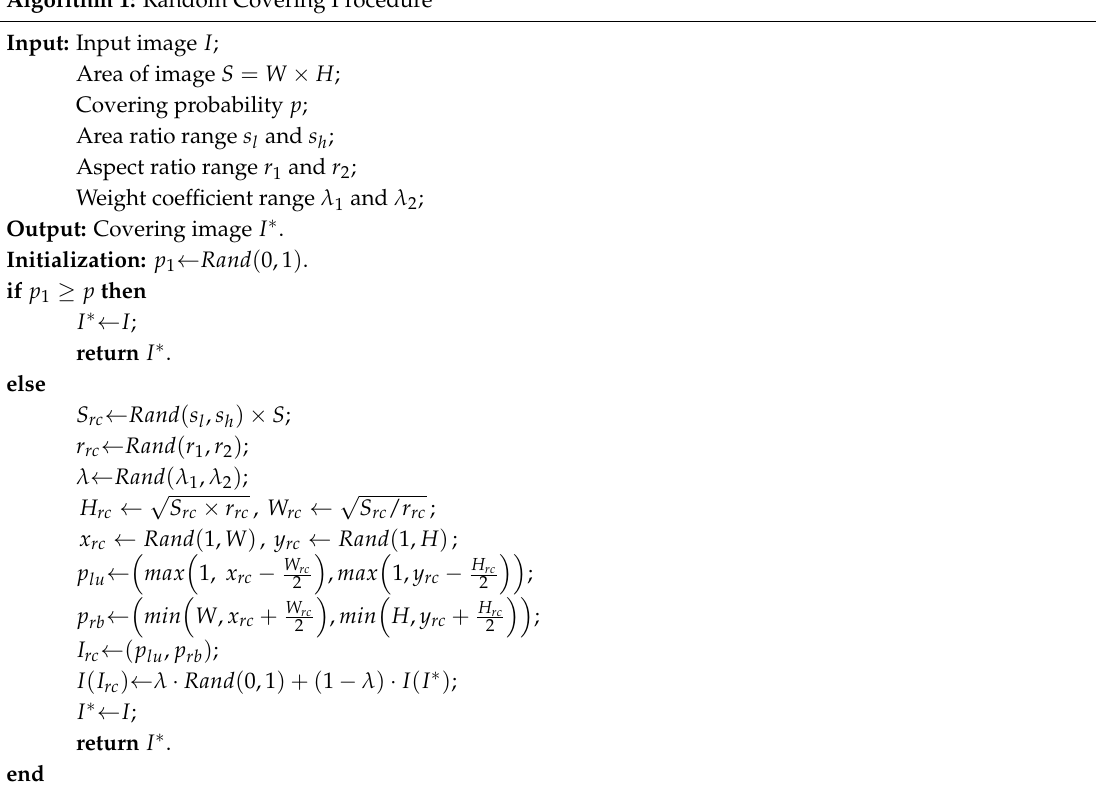
Algorithm 1: Random Covering